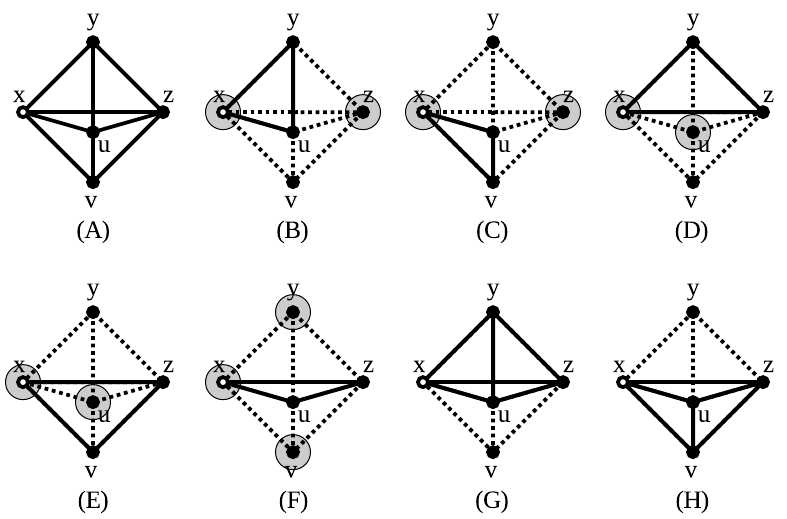
Fig 9. Use of an equation. (A) The explored graph in which Eq (14) is tested. Vertex x , colored white, is the inspected vertex. (B-F) The graph is shown in dotted lines, edges in full lines show all different graphlets where vertex x touches orbit 3. Vertices on a gray background are common neighbors of both other vertices of those graphlets. (G-H) The two graphlets in which vertex x touches orbit